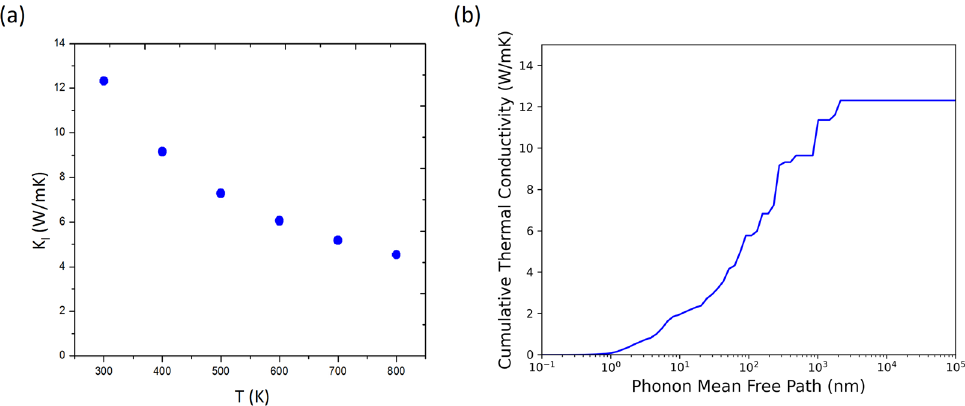
Figure 3. ( a ) The temperature dependent lattice thermal conductivity and ( b ) the cumulative ther- conductivity at 300K with respect to phonon MFP for the monolayer